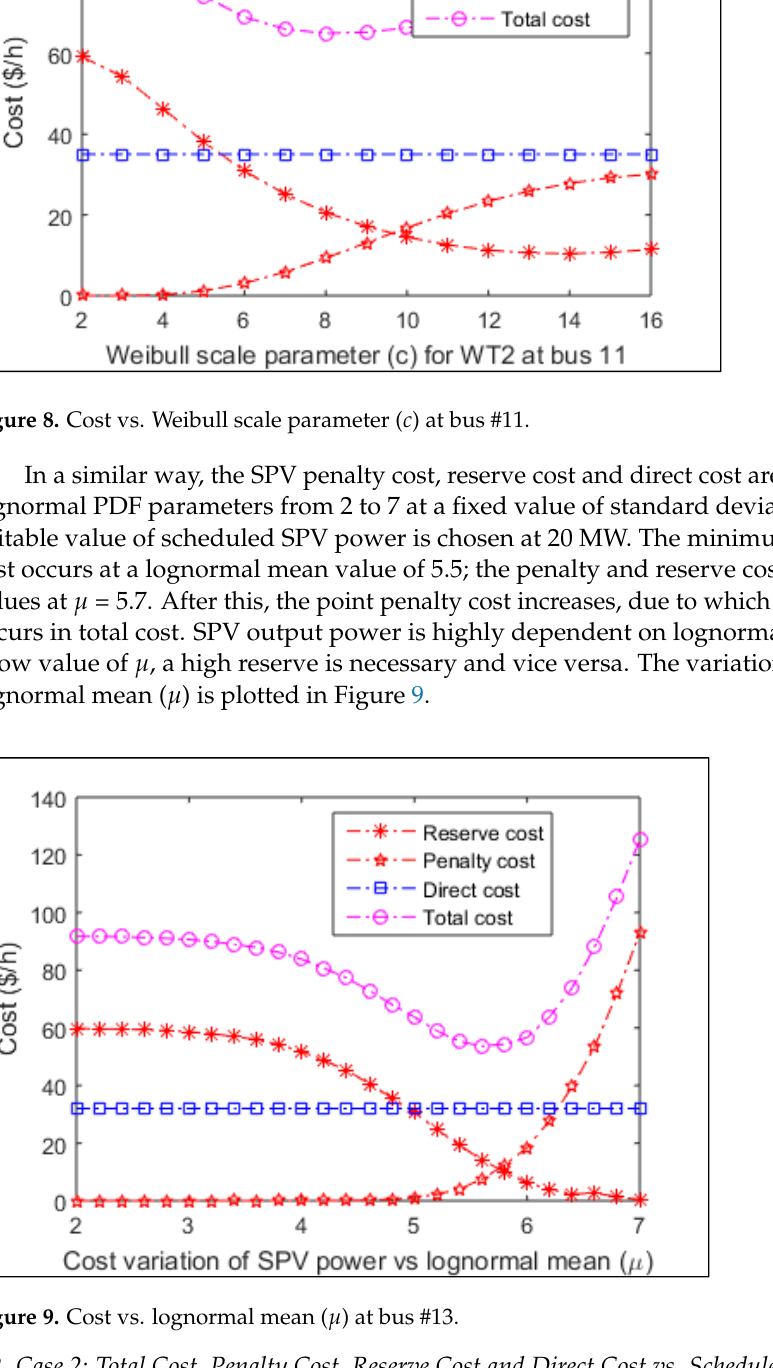
Figure 9. Cost vs. lognormal mean ( μ ) at bus #13.